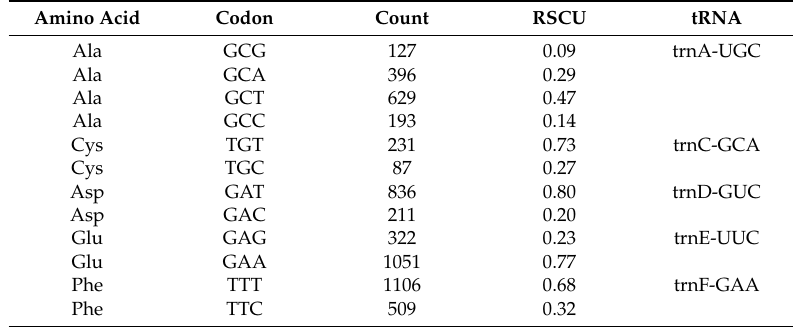
Table 3. Codon Usage for Cyamopsis tetragonoloba